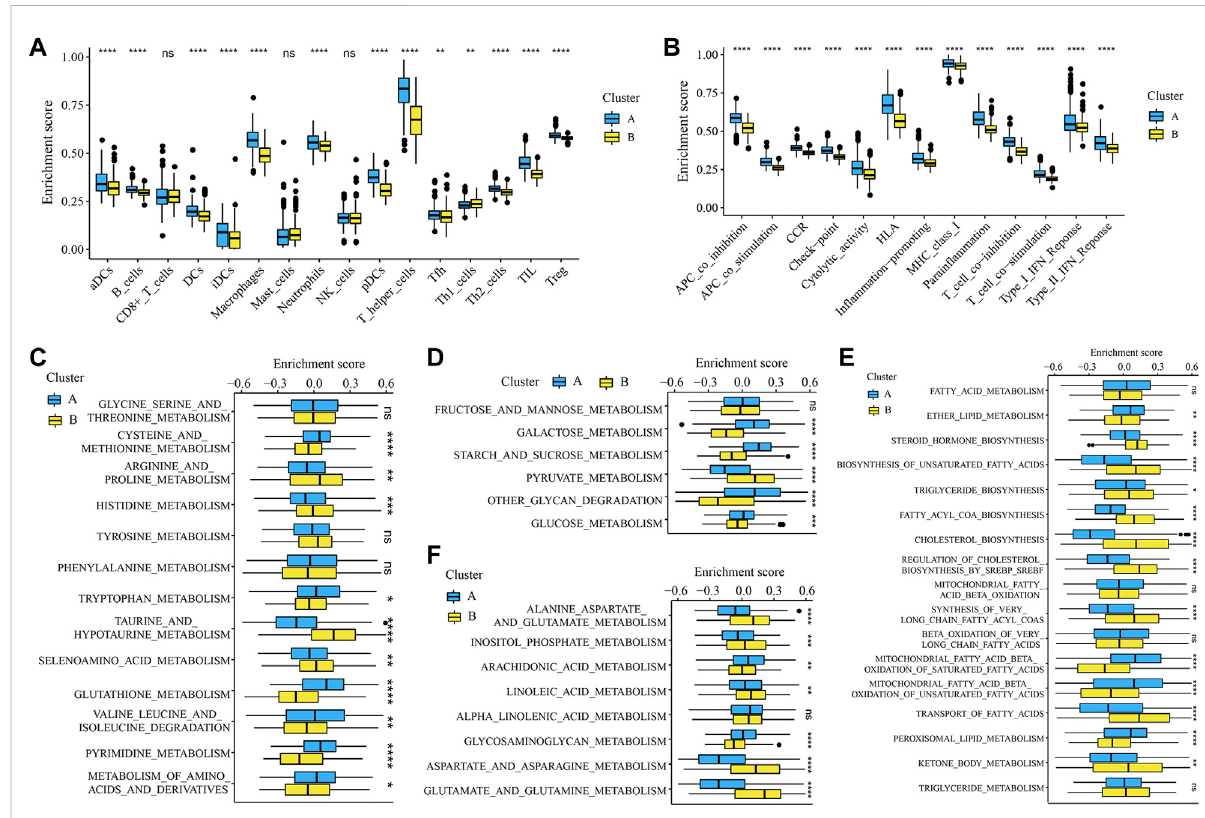
FIGURE 4 Immune microenvironment and metabolism features of the glycosylation clusters. * p < 0.05; ** p < 0.01; *** p < 0.001; **** p < 0.0001; ns, not signi fi cant. The boxplots showed the enrichment scores of (A) immune in fi ltrations and (B) immune functions differed in the clusters. Boxplots depicted the differences in enrichment scores of metabolism-associated processes between glycosylation clusters, which included (C) amino acid metabolism, (D) carbohydrates metabolism, (E) lipid metabolism, and (F) other metabolism.